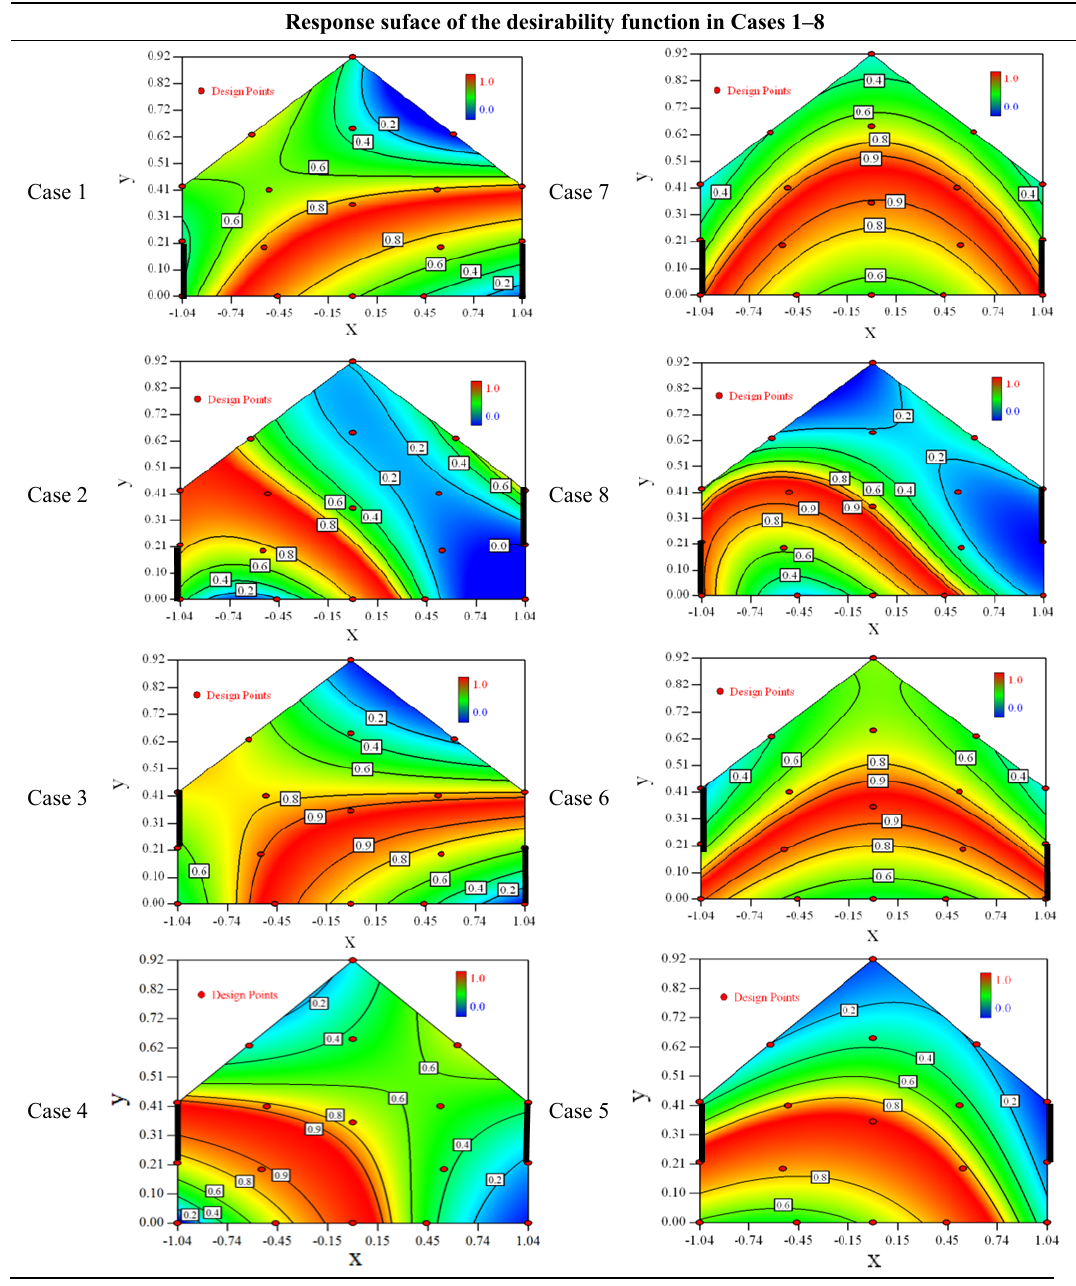
Table 6. Contours of the response suface of the desirability function for different experiemntal cases (Cases 1–8). The black bars in the plots represent the obstacles in the sidewall openings.In the plot, the incoming wind blows from the right side to the